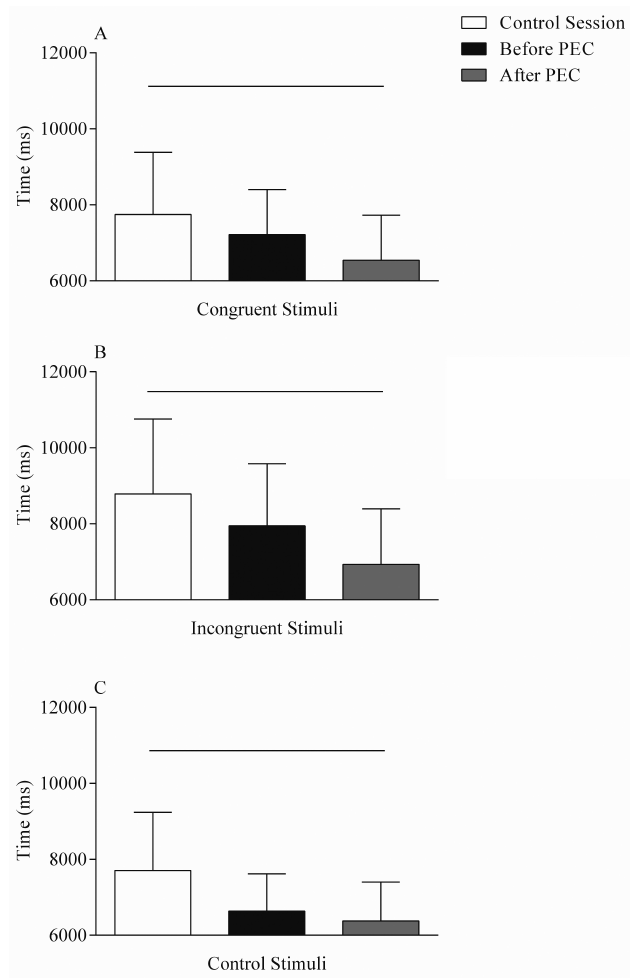
Figure 4. Results for reaction time for each stimuli in Stroop Test, for control session (white bar), before PEC (black bar) and after PEC (gray bar). Figure 4A showed reaction time for congruent stimuli (p = 0.000; F = 28.995; d = 1.439, very large ES). Figure 4B showed reaction time for incongruent stimuli (p = 0.000; F = 33.155; d = 1.539, very large ES). Figure 4C showed reaction time for control stimuli (p = 0.000; F = 72.689; d = 2.227, extremely large ES. Only Stroop Test outcomes obtained before the PEC were